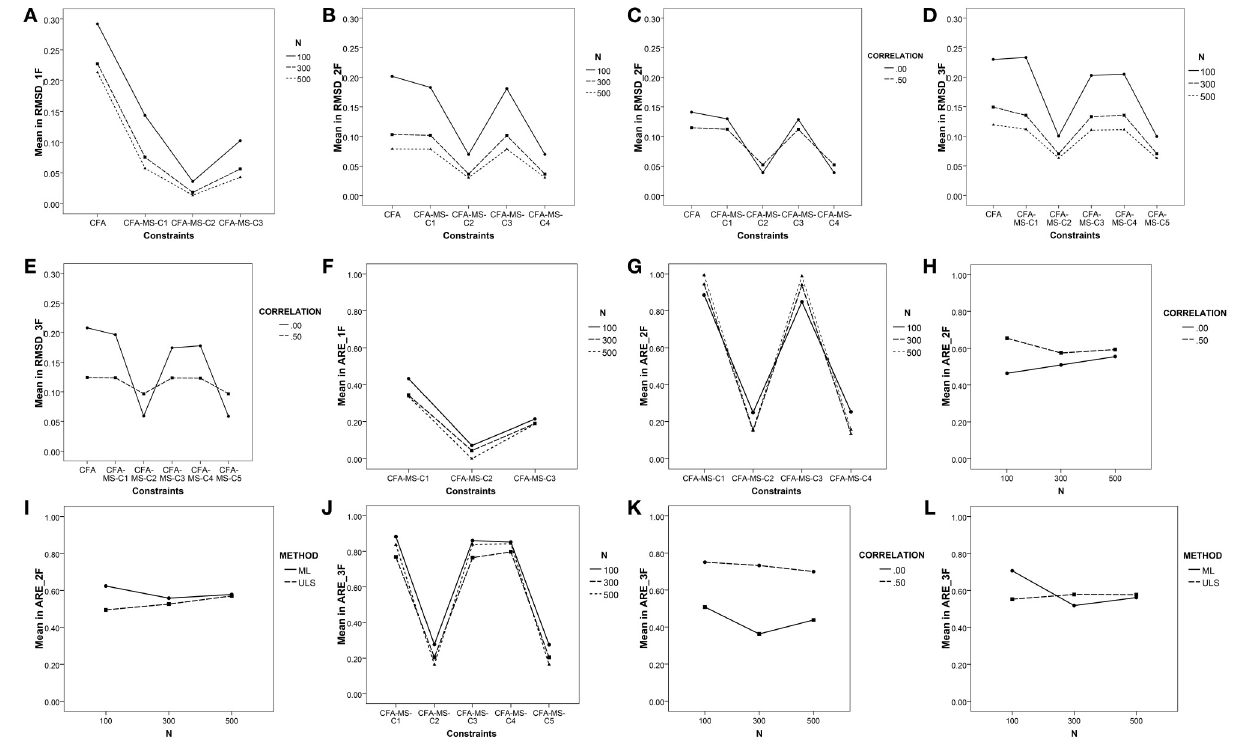
no case did ML outperform ULS in the recovery of weak factor